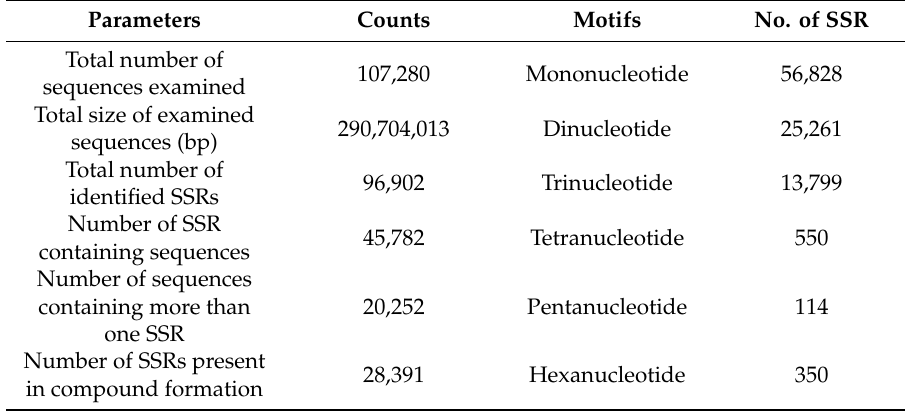
Table 3. Statistics of discovered simple sequence repeats (SSRs) and their various classes in rose